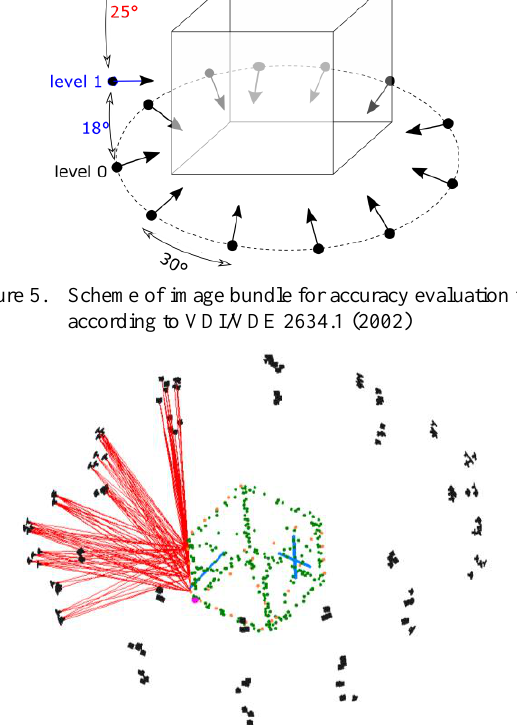
Figure 6. Visualisation of acquisition network (green: object points, orange: points of artefacts, blue: scales; black: camera stations, red: image rays)